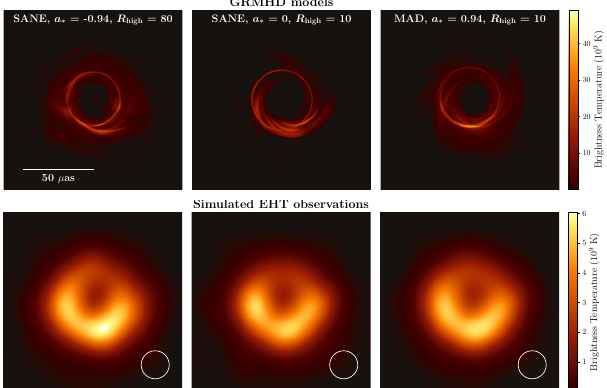
Figure 6. Synthetic EHT observations of M87*. Top : Ray-traced general relativistic magnetohy- drodynamics (GRMHD) simulations [171] from the EHT library with different black hole spins, electron temperature parameters, and magnetic field states (“MAD” versus “SANE”). Bottom : SYMBA synthetic observations corresponding to these models. Reproduced from Event Horizon Telescope Collaboration and et al.